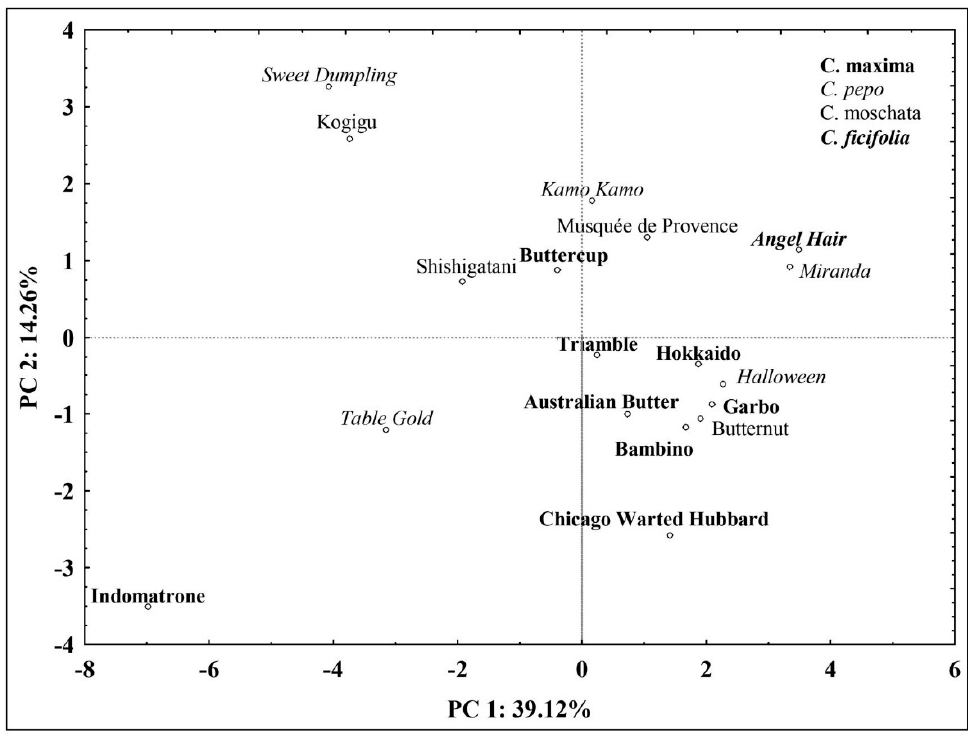
Figure 2. PCA score plot for Cucurbita cultivars, PC 1—principal component 1, PC 2—principal component 2. Table 5. Eigenvalues, percentage of variance and cumulated percentage of variance for the first five principal components obtained in the PCA